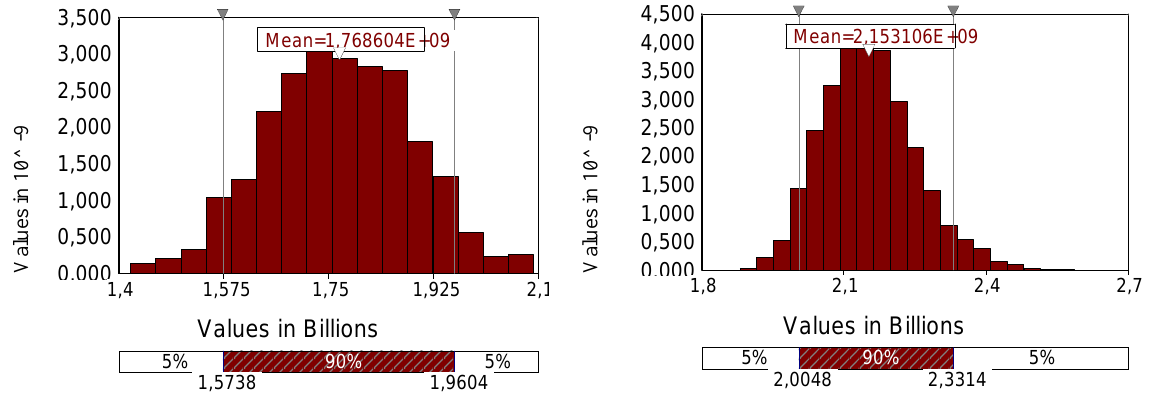
Fig 5. Comparison of estimated investment costs for the ICE (left graph) and the Transrapid (right